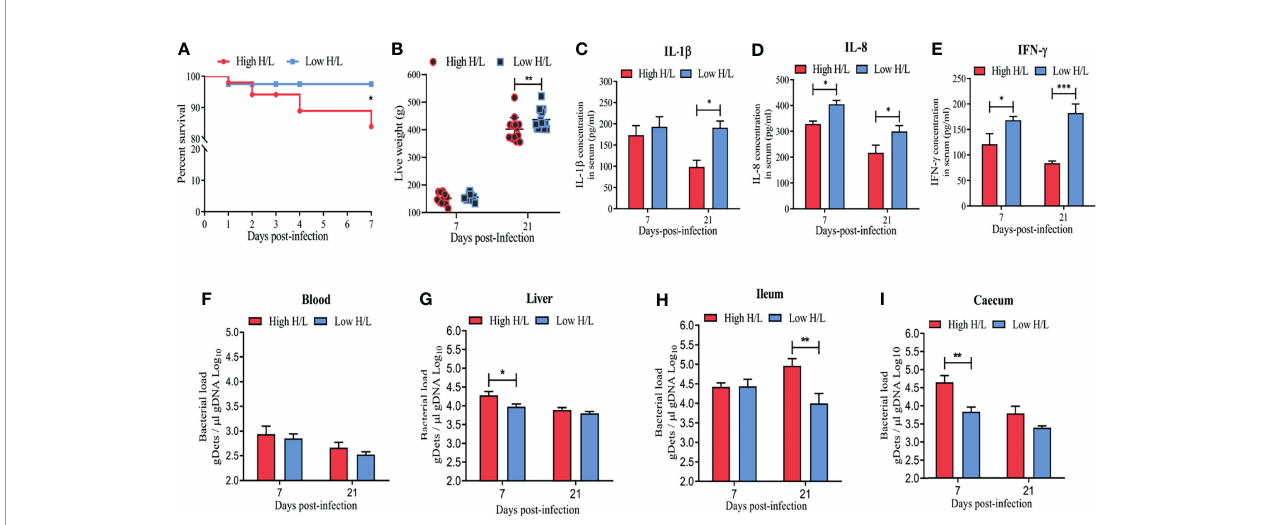
FIGURE 1 | Low H/L ratio chickens exhibit resistance advantages and reduced S . Enteritidis load. After infection by oral gavage with 1ml of PBS containing 10 10 CFU/ml of SE, the (A) Survival curve Kaplan-Meier; (B) body weight post-SE-infection (11-15 birds were used); (C) IL-1 b blood serum concentration difference between low and high H/L ratio SE-infected chickens at 7 and 21 dpi; (D) IL-8 blood serum concentration difference between low and high H/L ratio SE-infected chickens at 7 and 21 dpi; (E) IFN- g blood serum concentration difference between low and high H/L ratio SE-infected chickens at 7 and 21 dpi; Quanti fi cation of total S . Enteritidis gDets in different segments of the gastrointestinal tract, blood, and Liver was performed by quantifying the Sdf1 (total bacteria, Salmonella different fragment 1 sequence by qPCR. gDNA from Blood (F) , Liver (G) , Ileum (H) , Caecum (I) were puri fi ed and the presence of S . Enteritidis was identi fi ed, the number of copies for each sequence was normalized per m l of gDNA. The assay was performed in triplicate and included 4 to 6 chickens per group for each time point post- infection, except the bacterial load from liver that included 3 birds at 21 dpi. *p < 0.05, **p < 0.01, ***p < 0.001. Signi fi cance was determined using 2-way ANOVA with Sidak ’ s multiple comparisons, with 95% con fi dence